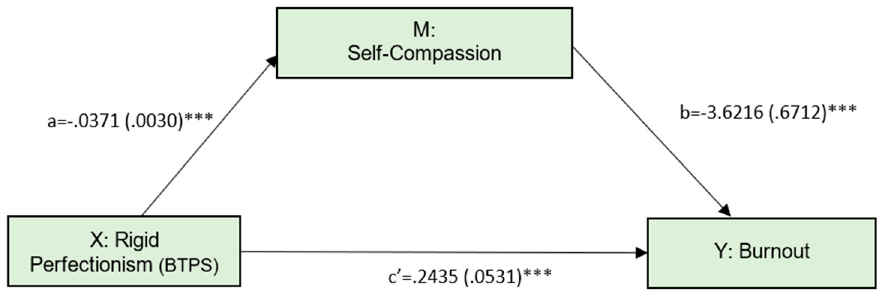
Figure 2. Simple mediation model, with rigid perfectionism as the predictor. Numbers represent unstandardized coefficients. Numbers in parentheses represent standard errors. *** p < 0.001.